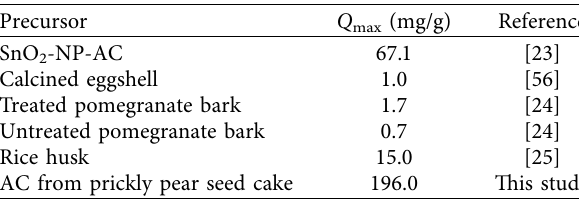
Table 6: Maximum capacities for MX on various adsorbents.